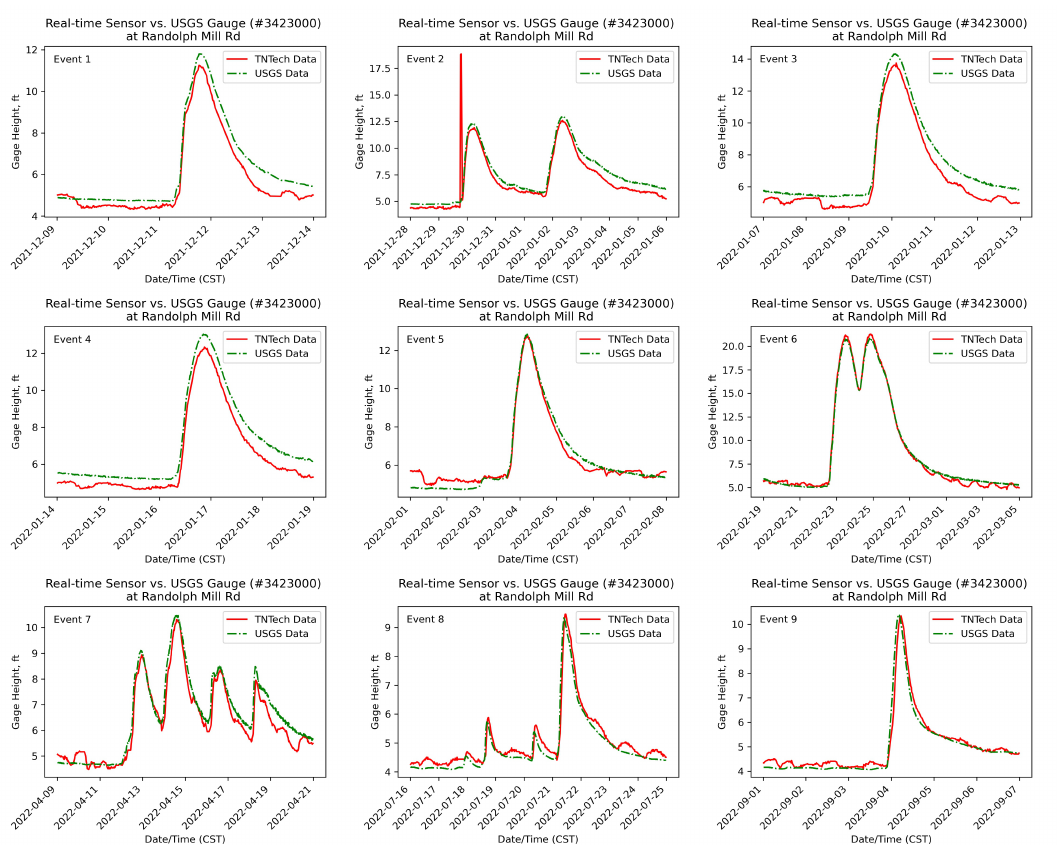
Figure 6. Hydrograph comparison for all nine